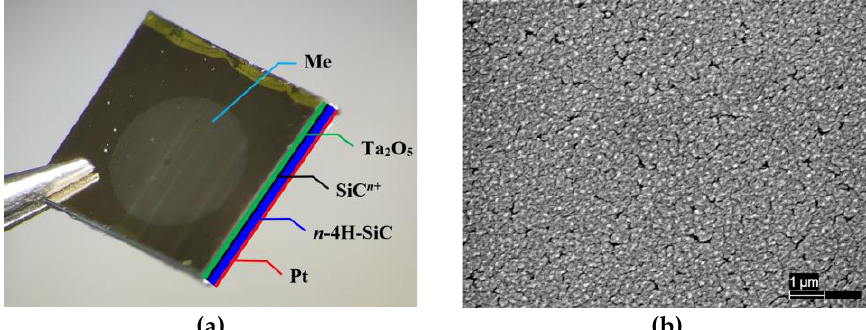
Figure 2. The MOS structure’s scheme used in this work: the sequence of layers from top to bottom Me/Ta 2 O 5 /SiC n+ /4H-SiC/Pt, where “Me” is the upper metal gate film with a diameter of 2.5 mm ( a ). SEM photograph of the palladium electrode porous surface ( b ).